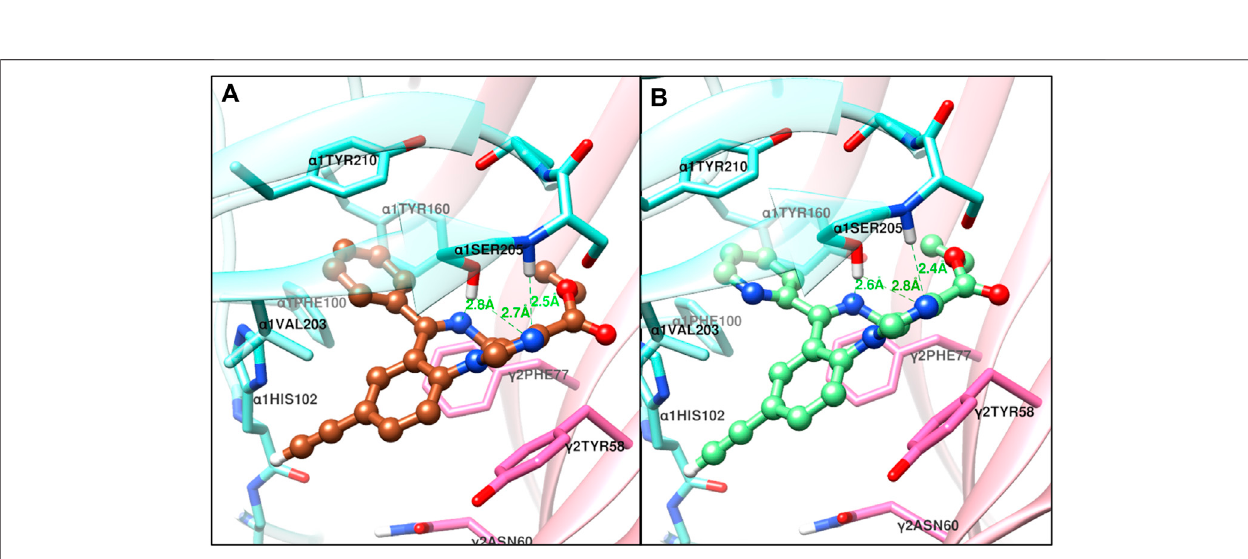
FIGURE8| Thedockedcon fi rmationsofXHe-II-053(sienna)andHZ-166(lightgreen)inthecomplexwiththe α 1 β 3 γ 2LGABA A receptor6HUOatthe α + γ − interface benzodiazepine binding site [ α 1 (aquamarine) and γ 2 (orchid)], dashed lines indicate hydrogen bonds (green) and halogen bond (black).